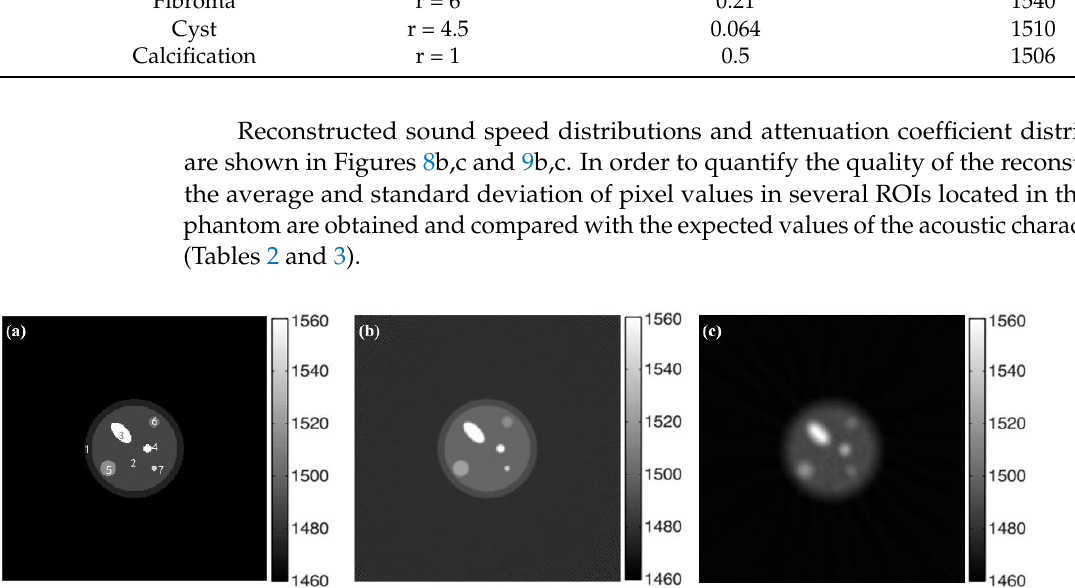
Figure 8. Reconstructed sound speed distribution. ( a ) Original sound speed distribution. ( b ) Reconstructed through time-reversal. ( c ) Reconstructed through FBP.